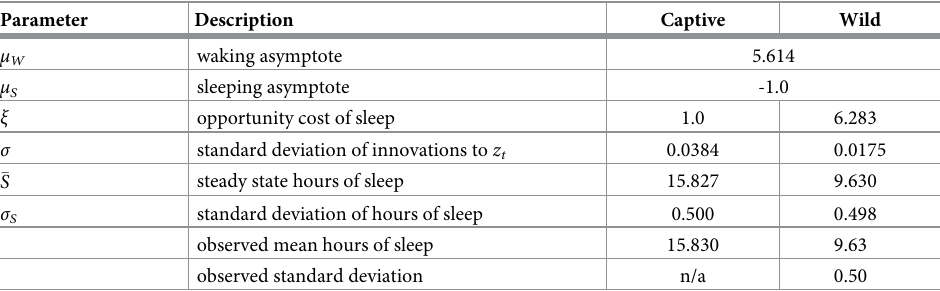
Table 2. Model parameters, predicted and actual sleep for